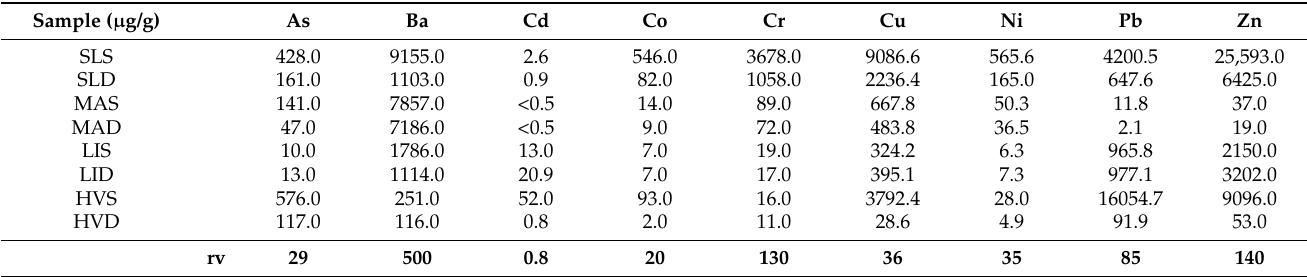
Table 1. Risk elements concentrations in the samples of studied